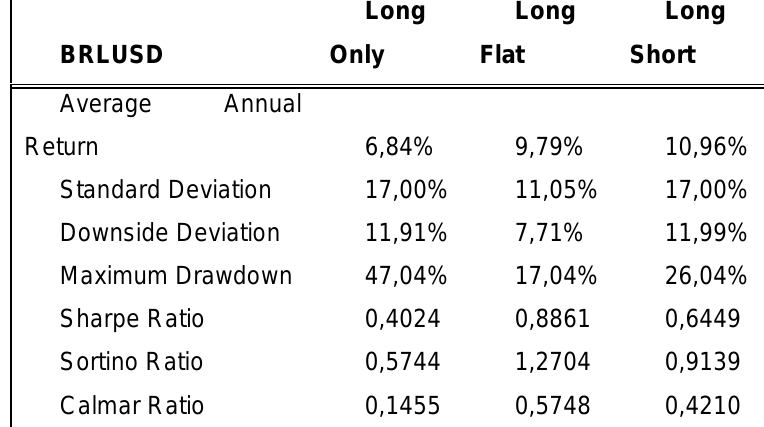
Table 2 . Results of the carry strategies on the BRL 5:2000-5:2018, daily data.